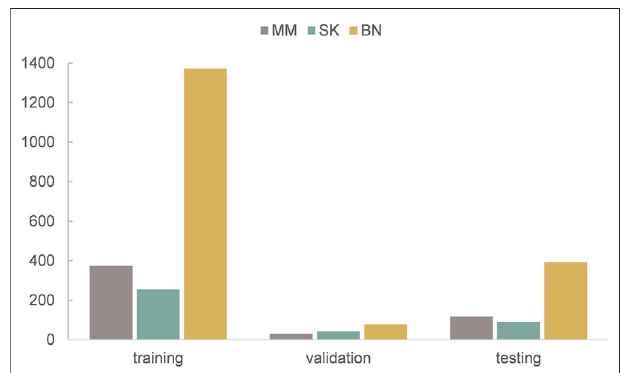
FIGURE 5 | The distribution of training, validation, and test sets of ISIC 2017 challenge dataset.